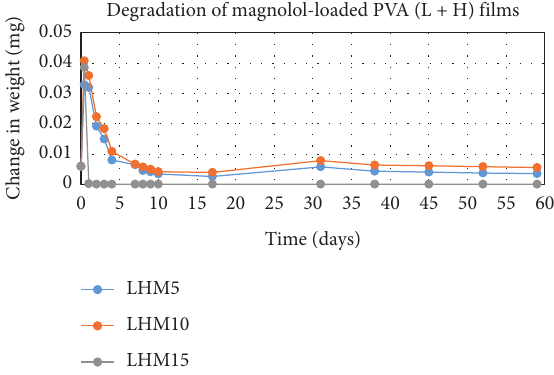
Figure 4: Degradation of magnolol-loaded PVA (L +H)